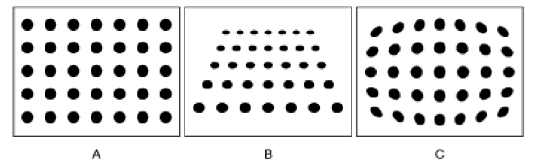
Figure 6. Typical Perspective and NonLinear Distortion effects on Imaging Systems